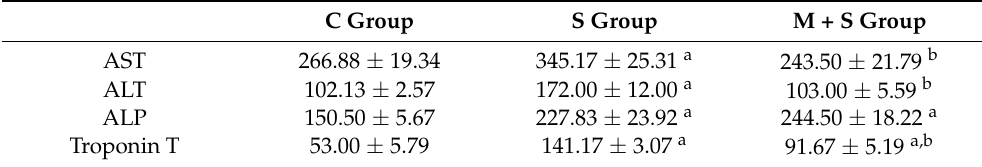
Table 1. The aspartate aminotransferase (AST), alanine aminotransferase (ALT), and alkaline phos- phatase (ALP) activities (IU/L), and serum Troponin T concentration (ng/L) in rats of control (C), sepsis (S), and meldonium + sepsis (M + S) groups. The number of animals per experimental group: n = 8. The data are given as mean ± standard error of the mean. Minimal significance level: p < 0.05. Significantly different: a in respect to the C group; b in respect to the S group. C Group S Group M + S Group AST 266.88 ± 19.34 345.17 ± 25.31 a 243.50 ± 21.79 b ALT 102.13 ± 2.57 172.00 ± 12.00 a 103.00 ± 5.59 b ALP 150.50 ± 5.67 227.83 ± 23.92 a 244.50 ± 18.22 a Troponin T 53.00 ± 5.79 141.17 ± 3.07 a 91.67 ± 5.19